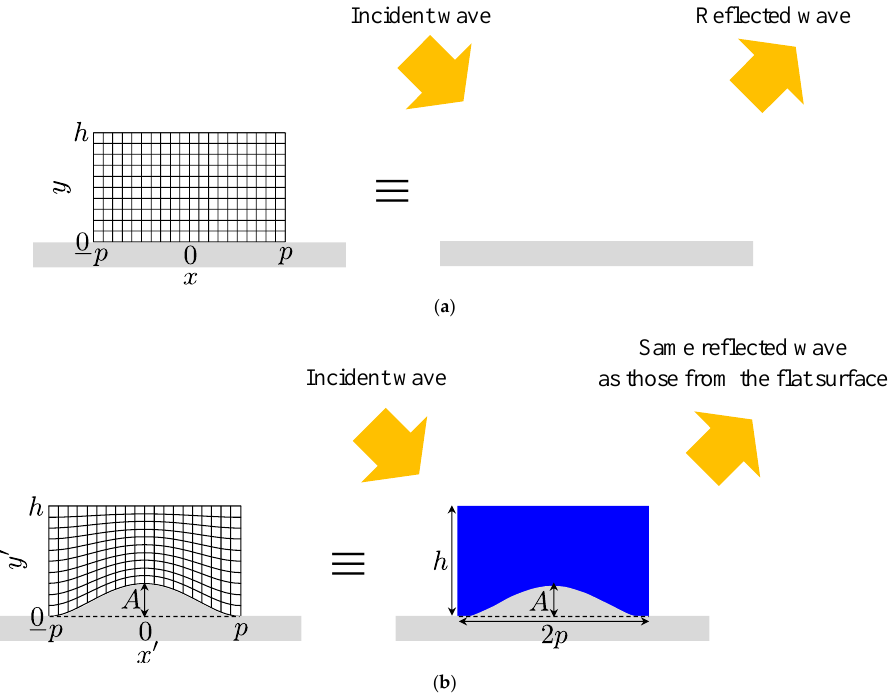
Figure 6. Concept of an acoustic carpet cloak. ( a ) Original coordinate system on a flat surface and the reflection from the flat surface; ( b ) transformed coordinate system on a bump and the reflection from an acoustic carpet cloak covering the bump. The same reflected wave as that from the flat surface is generated by controlling the trajectory of the incident acoustic wave, with the carpet cloak mimicking the transformed coordinate system and it looks as if there is not the bump on the flat surface.